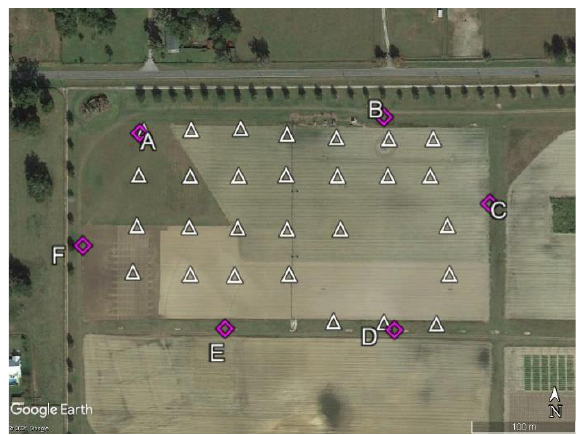
Figure 1. Overview of study site. Control points A-F (magenta) labelled, and target locations shown as white triangles. The area in the southeast corner was avoided so as not to disturb another experiment in progress. (Base imagery courtesy Google Earth)